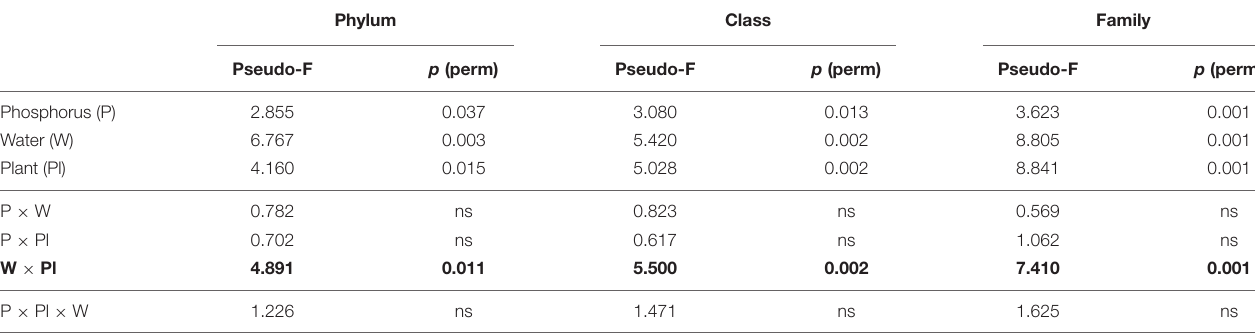
TABLE 2 | PERMANOVA results testing for differences between experimental treatments within the D5 sub-section of mesocosms.